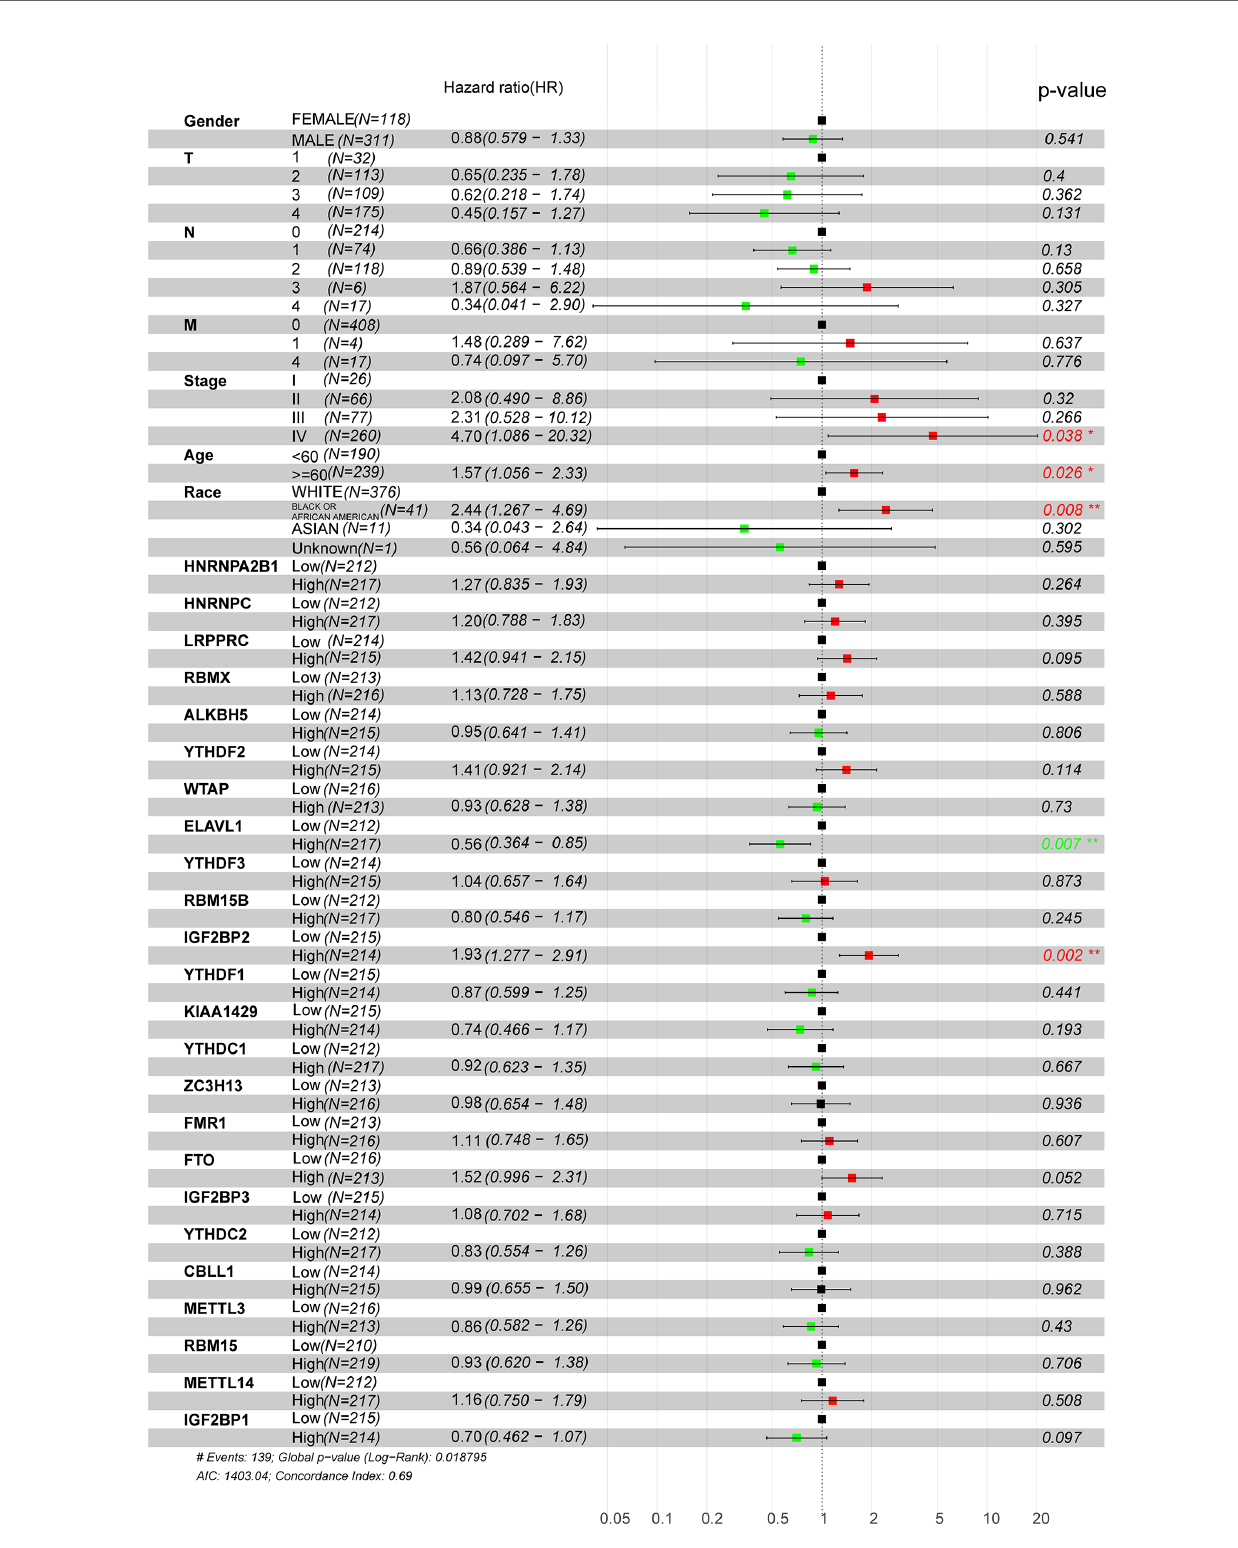
FIGURE 2 | Univariate Cox regression analysis of m 6 A regulators in HNSCC patients in the TCGA dataset. Tumor node metastasis classi fi cation: T (tumor), N (lymph node), and M